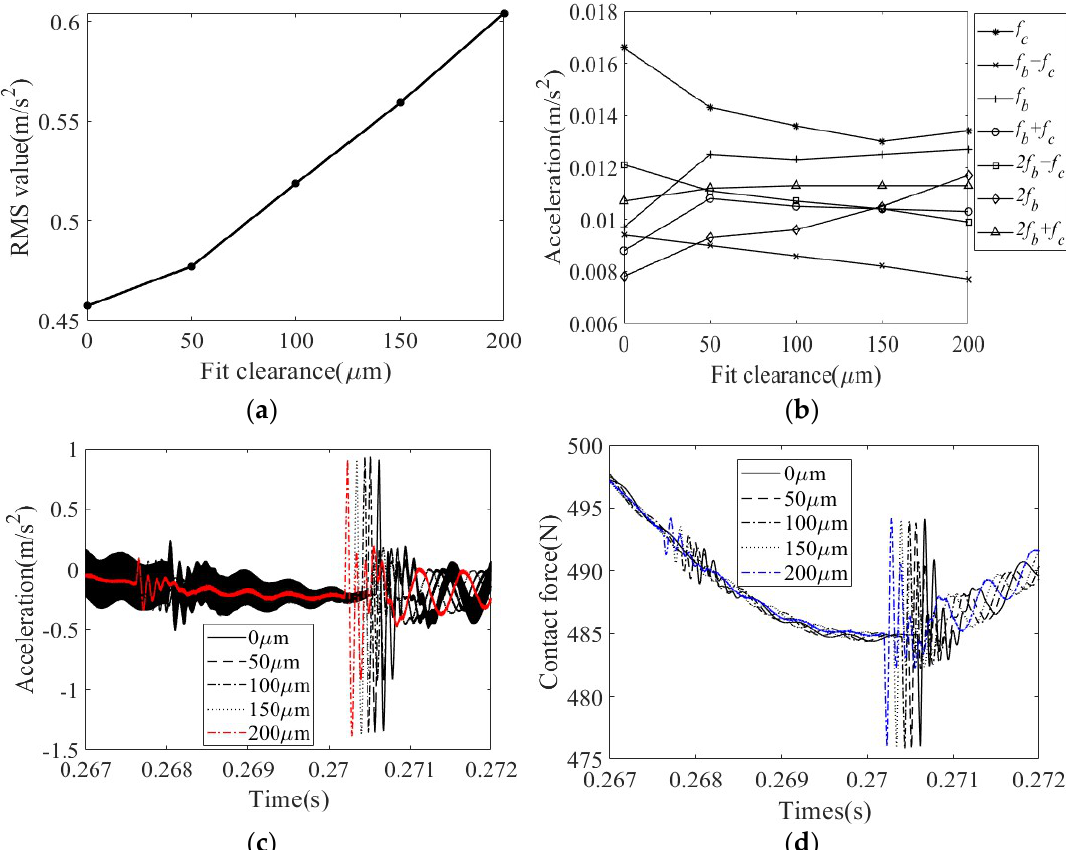
Figure 23. The vibration characteristics of the bearing under roller defect and fit clearance: ( a ) RMS; ( b ) amplitudes of f c , f b − f c , f b , f b + f c , 2 f b − f c , 2 f b , 2 f b + f c ; ( c ) housing acceleration signal from 0.267 s to 0.272 s; ( d ) contact force between outer ring and housing from 0.267 s to 0.272 s.